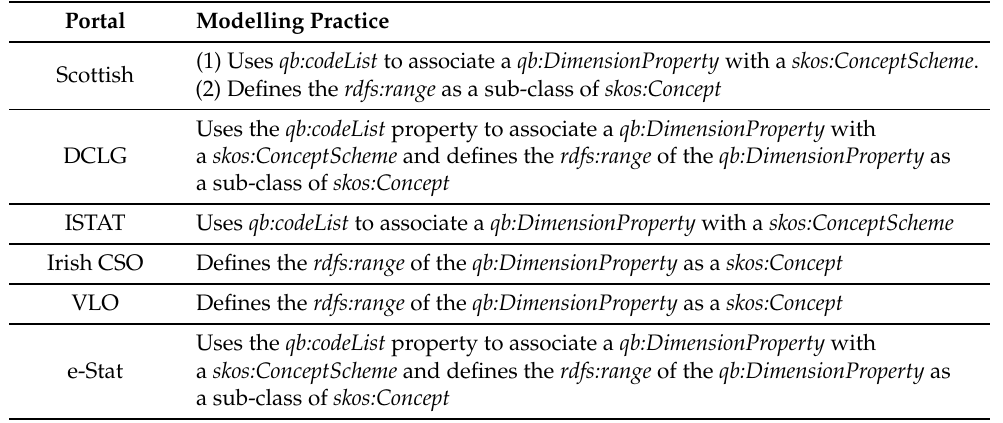
Table 37. Modelling practices of data portals for associating dimensions to code lists.